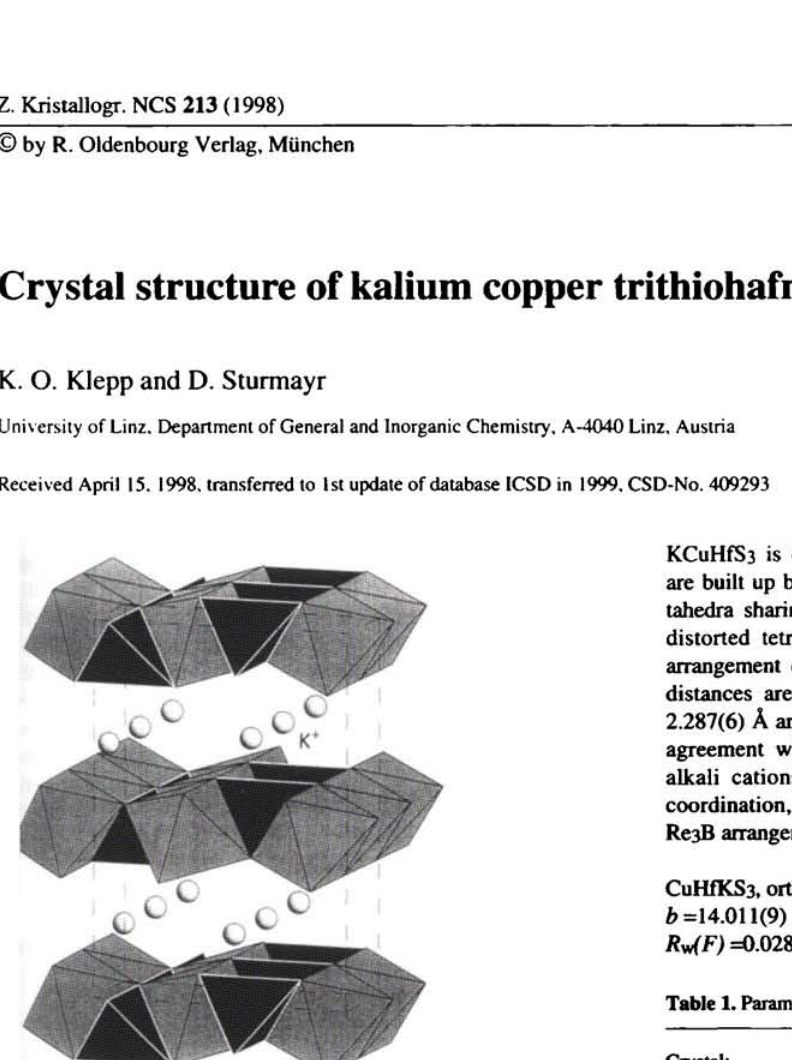
Source of material: KCuHfSs was obtained by reacting a stoichio- metric mixture of K2S with Hf (99.8%), Cu (99.99%) and S (99.99%) powders in an evacuated silica ampoule at 12(Ю К, followed by slow cooling.